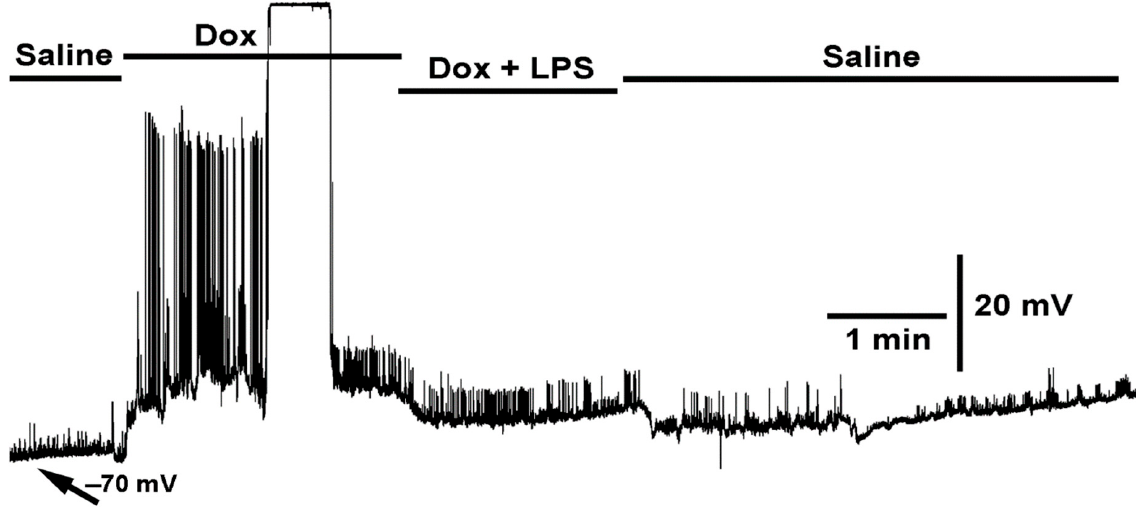
Figure 3. The effect of doxapram (10 mM) and the cocktail of doxapram (10 mM) and LPS on membrane potential and synaptic transmission. Exposure to doxapram (10 mM) rapidly depolarizes the membrane potential and evoked responses, from transected segmental nerves from the CNS. The motor neurons depolarize producing excitatory junction potentials (EJPs) of similar amplitude as those of electrical evoked nerve EJPs. The barraged of depolarizations dislodged the intracellular recordings. The bath exchange to doxapram and LPS produced small hyperpolarization while small EJPs and mEJPs are still present. Upon exchanging to fresh saline, free of doxapram and LPS, the membrane potential almost regained the initial resting membrane potential.